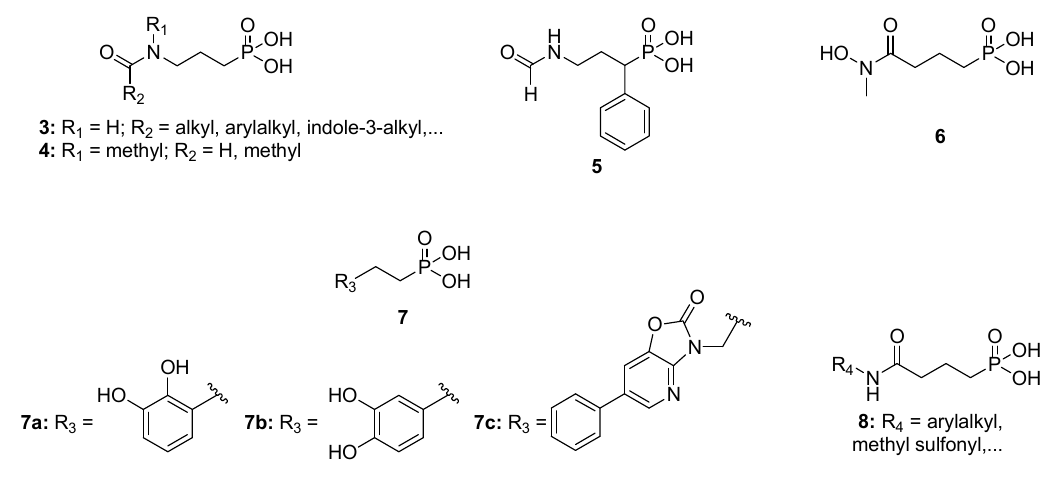
Figure 2. Hydroxamate-modified analogs of